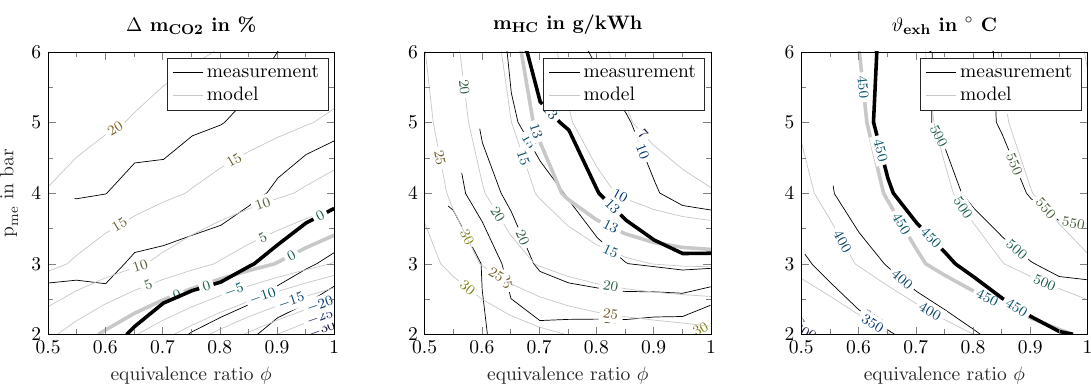
Figure 7. Comparison of measured and modeled low-load criteria with 0% EGR. The three figures show ( Left ) the CO 2 reduction, ( Center ) the HC engine-out emission and ( Right ) the exhaust gas = 0%, m HC = 13 g/kWh, and ϑ exh = 450 ◦ C are temperature. The limit values ∆ m CO 2